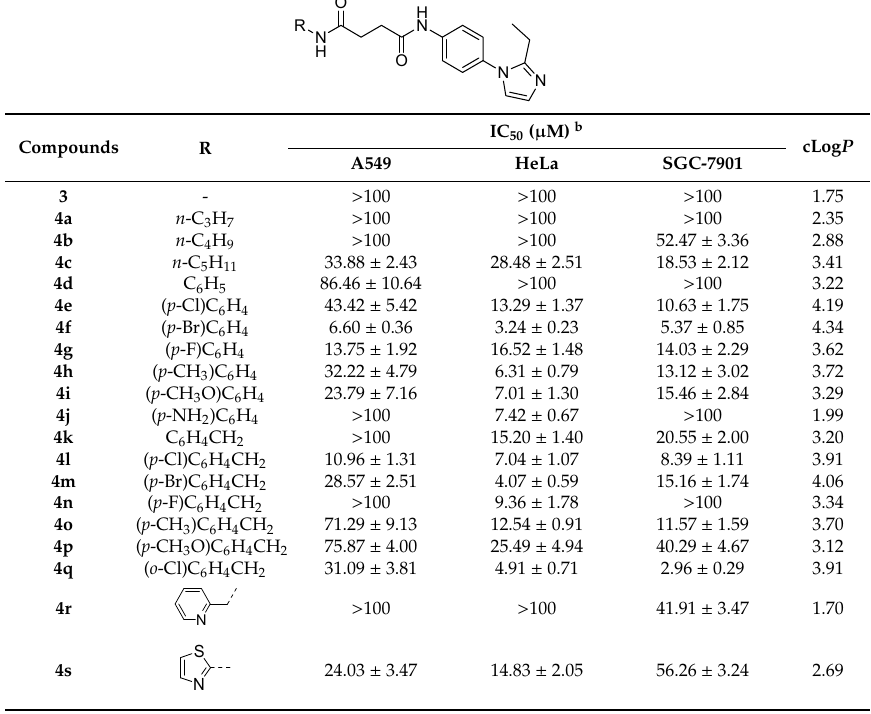
Table 1. IC 50 (µM) values of 5-FU, MTX, and the newly synthesized compounds in cancer cells a .